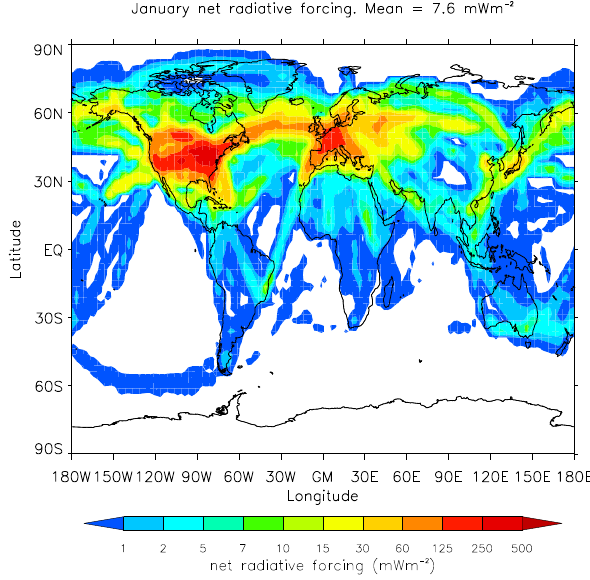
Fig. 2. Net January contrail radiative forcing for mean IWC.